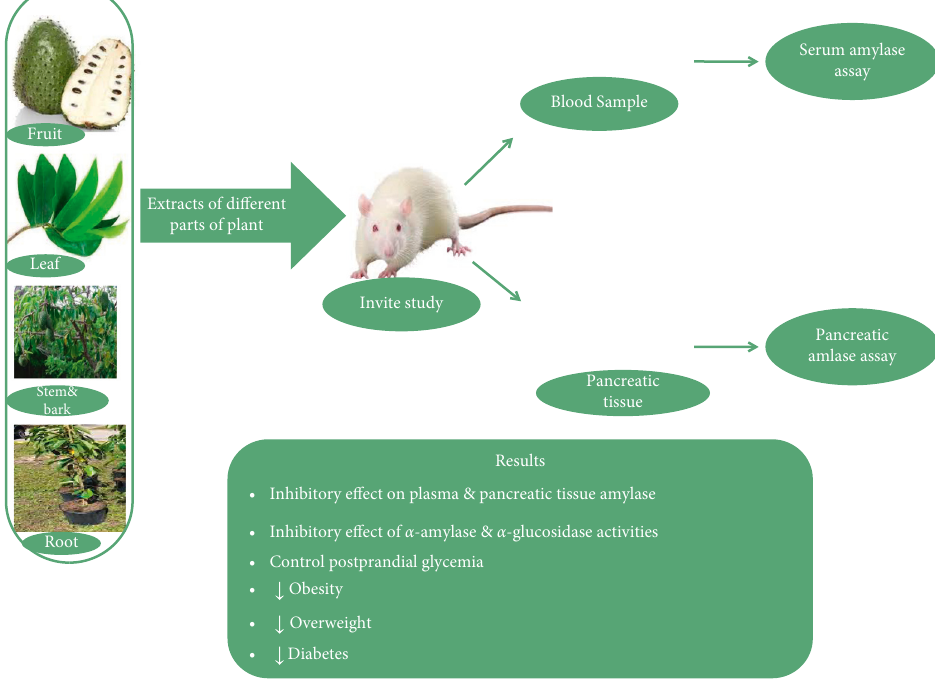
Figure 1: The antidiabetic activity of soursop